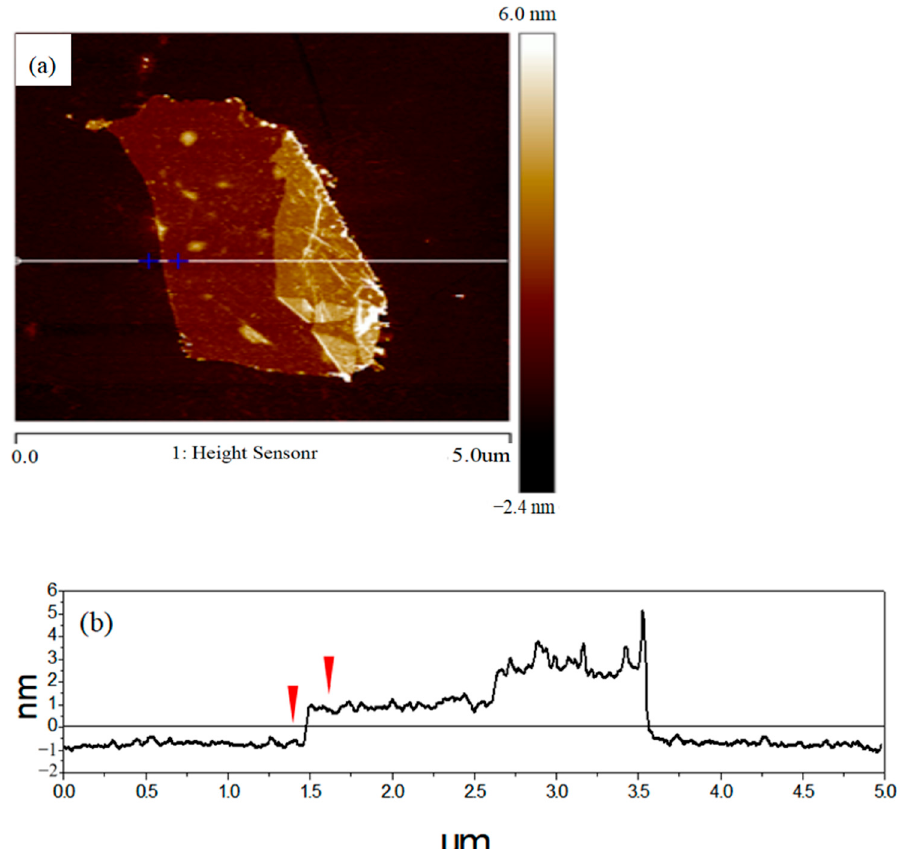
Figure 9. ( a ) AFM image of graphene on Si substrates and ( b ) corresponding height profile from the indicated white line and location. The location of anti-trigonometric indicator in Figure 9 ( b ) corresponds to the plus sign position of Figure 9 ( a ).